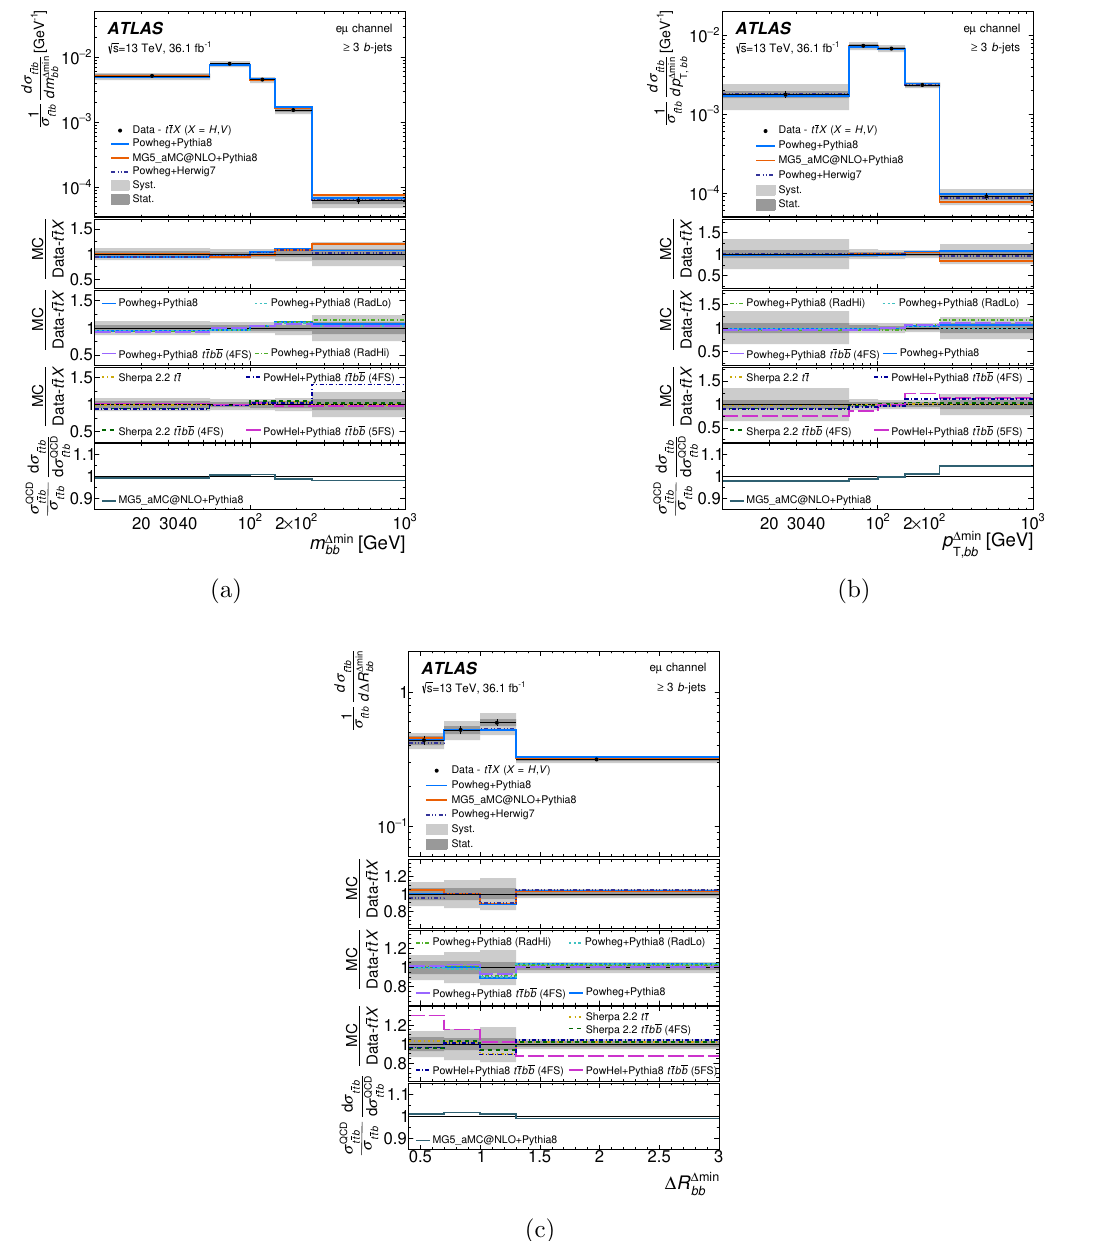
Figure 16. Relative di(cid:11)erential cross-sections as a function of (a) m (cid:1)min (cid:1) R (cid:1)min of two closest b -jets in (cid:1) R in events with at least three b -jets in the e(cid:22) channel com- bb pared with various MC generators. The t (cid:22) tH and t (cid:22) tV contributions are subtracted from data. Four ratio panels are shown, the (cid:12)rst three of which show the ratios of various predictions to data. The last panel shows the ratio of predictions of normalised di(cid:11)erential cross-sections from MadGraph5 aMC@NLO+ Pythia 8 including (numerator) and not including (denominator) the contributions from t (cid:22) tV and t (cid:22) tH production. Uncertainty bands represent the statistical and total systematic uncertainties as described in section 8. Events with observable values outside the axis range are not included in the